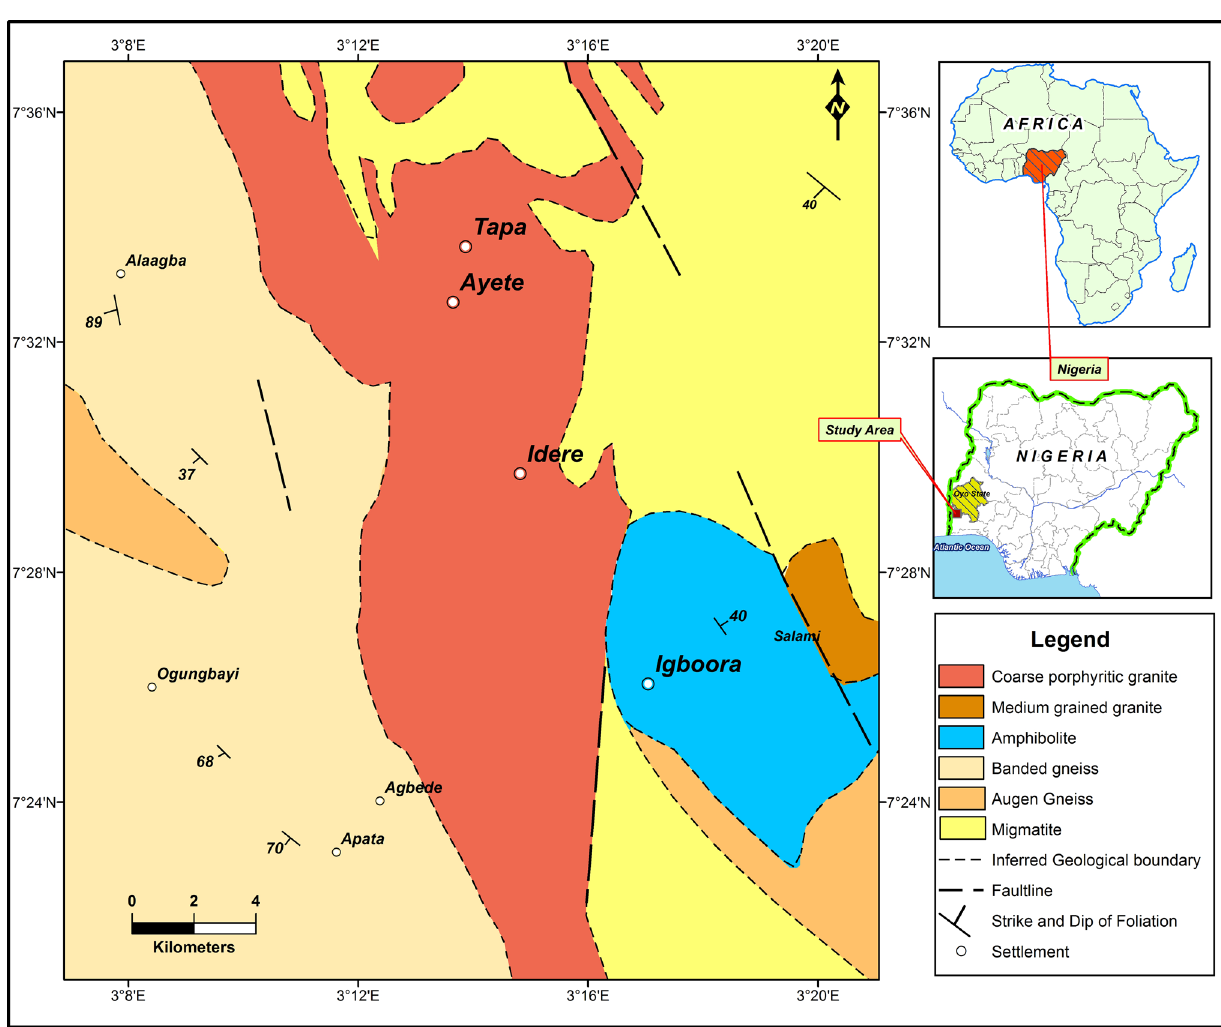
Fig. 2 Geological map of the study area (updated after Weerawarnakula